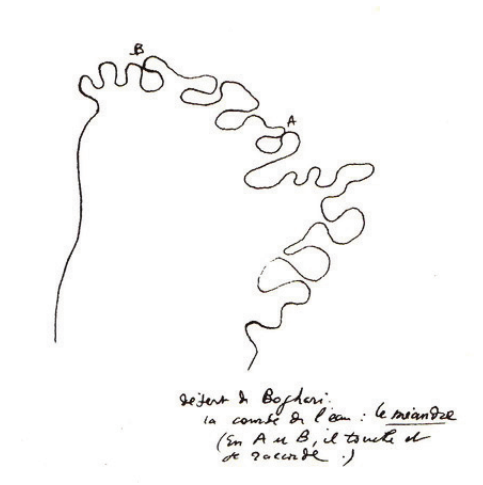
Fig. 6. Erbil (Irak) aerial view from Découverte aérienne du Fig. 5. Le Corbusier, Aircraft, (1935). Figure 122: monde. Chombart de Lauwe, Paul; Crochet-Damais, Pierre; “ Boghari desert. The water flow: The meander. At A and Marthelot, Pierre; Griaule, Marcel; Parent, Michel; Moraze, B connection points” Charles; Schlienger, Georges. Paris : Horizons de France.